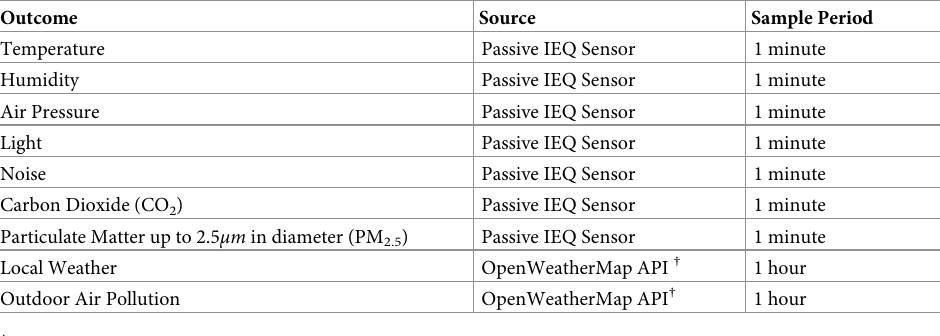
Table 2. Covariates to predict the primary